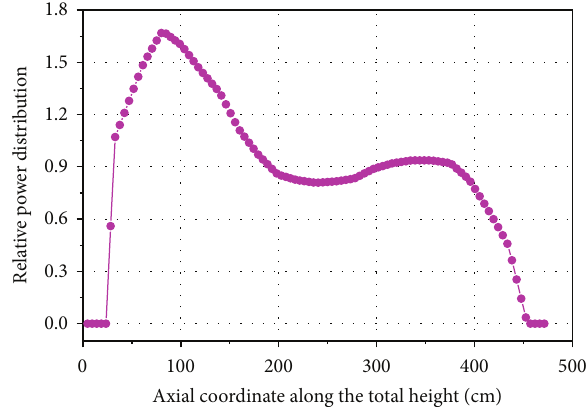
Figure 5: Relative power